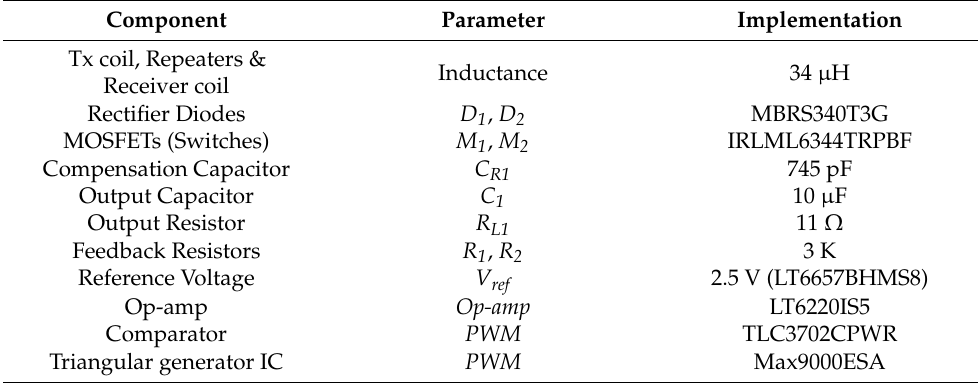
Table 2. Component